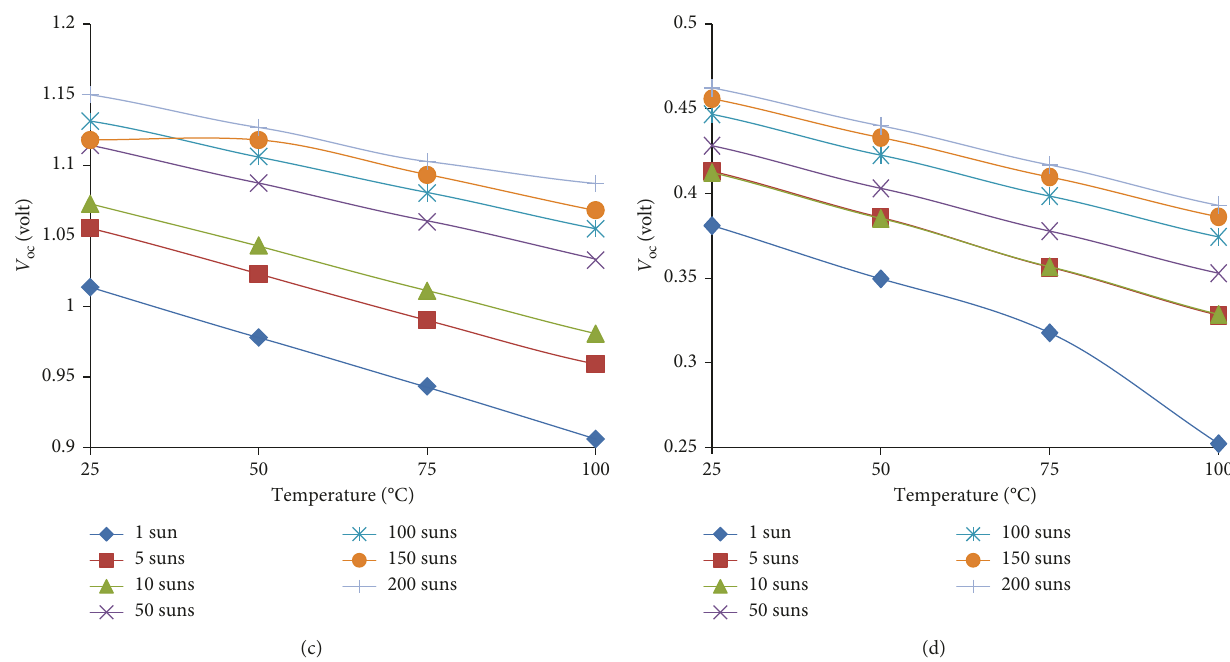
Figure 2: The effect of temperatures on (a) the efficiency of Al 0.3 Ga 0.7 As/InP/Ge multijunction solar cells. The effect of temperature on the open-circuit voltage of (b) the first subcell Al 0.3 Ga 0.7 As, (c) the second subcell InP, and (d) the third subcell Ge.